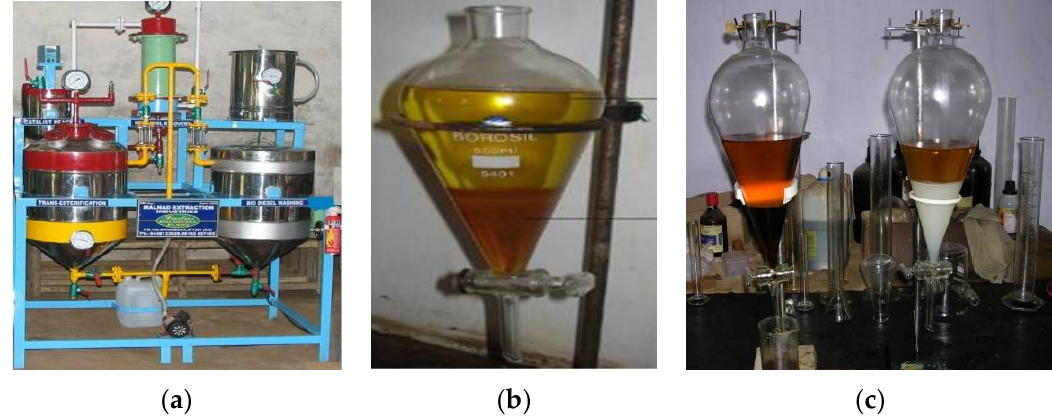
Figure 1. Biodiesel production process: ( a ) Setup for BDF production; ( b ) separation of glycerin from BDF; ( c ) dissolved catalyst removal from BDF [42].